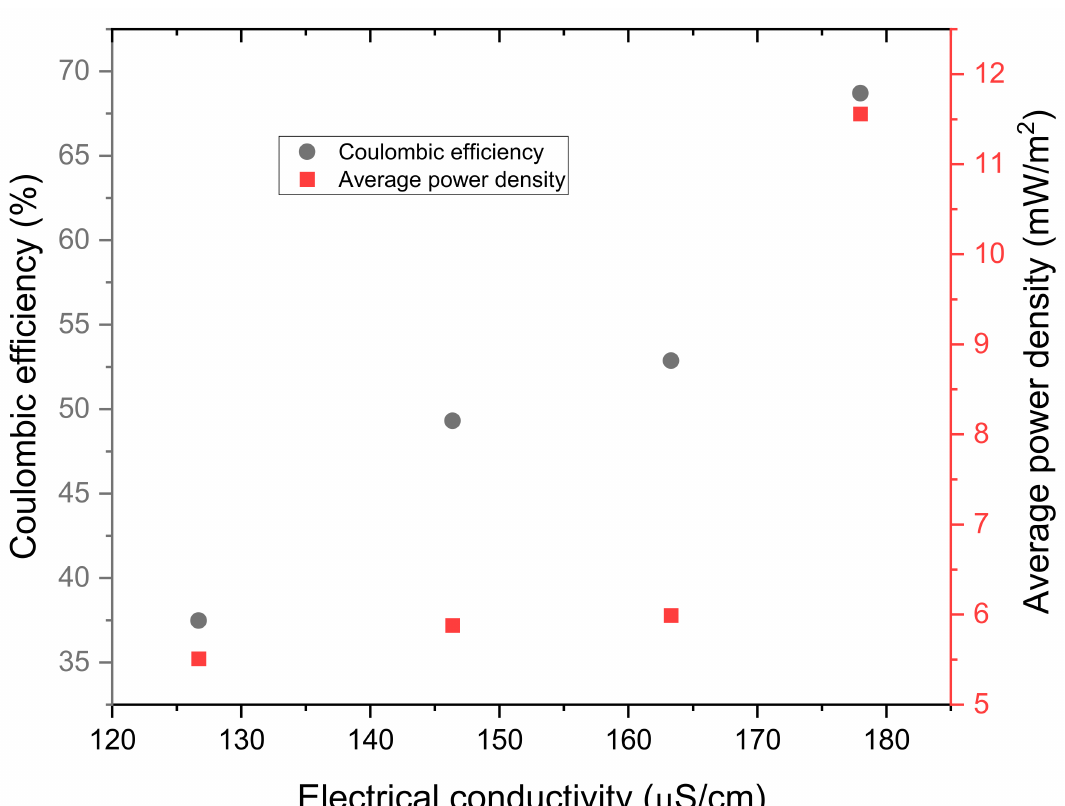
Figure 8. Coulombic efficiency and maximum power density as a function of electrical